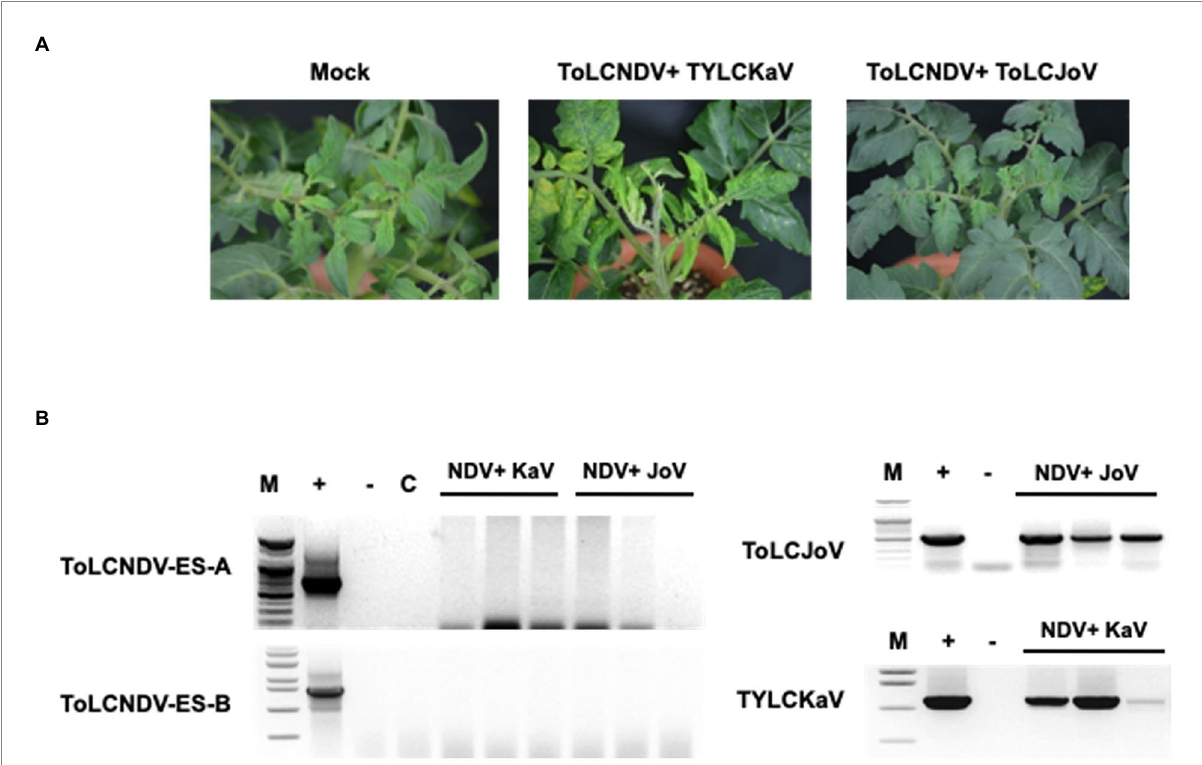
FIGURE 7 Results for co-inoculation between ToLCNDV-ES and other virus clones in tomato: (A) phenotype of San Pedro cv. plant after co-inoculation for 3 weeks. Viral phenotype was induced in mixed infection between TYLCKaV and ToLCNDV-ES. Combination with ToLCJoV showed asymptomatic phenotype compared to mock plants; (B) detection result by PCR amplification. Lane M: ladder, lane +: positive control, lane − : negative control, lane C: mock plant. All plants displayed no infectivity of ToLCNDV-ES even mixed with TYLCKaV or ToLCJoV. Infected plants showed only TYLCKaV and ToLCJoV